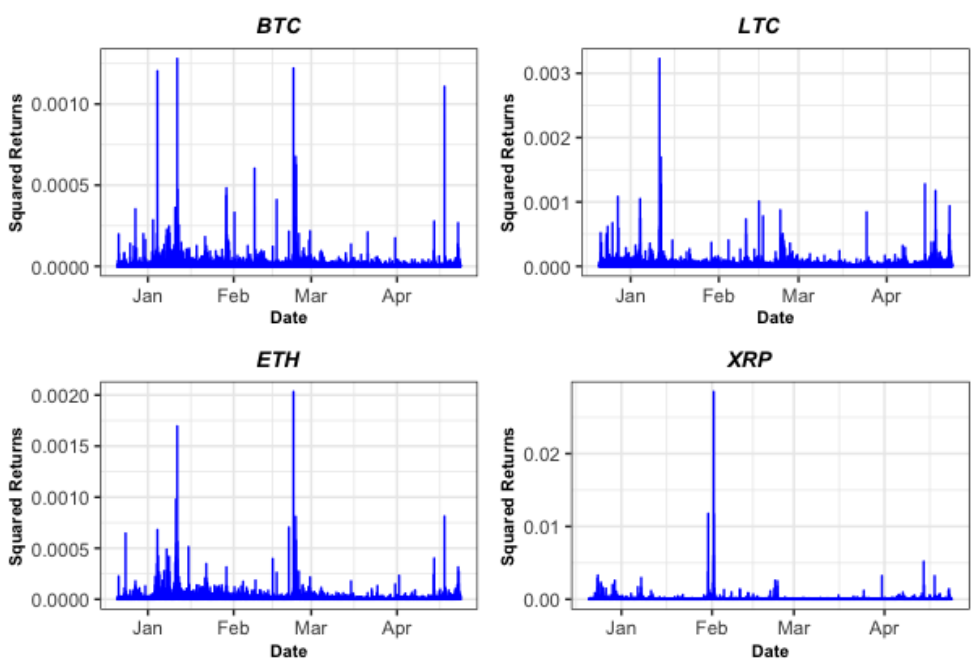
Figure 3. One-minute squared returns ( r t ) of all coins. Note: Data observation time period: 21